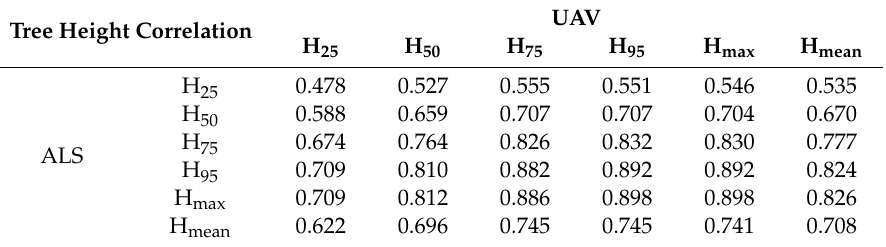
Table 4. Correlation between tree height data determined using UAV and ALS point clouds. Tree Height Correlation